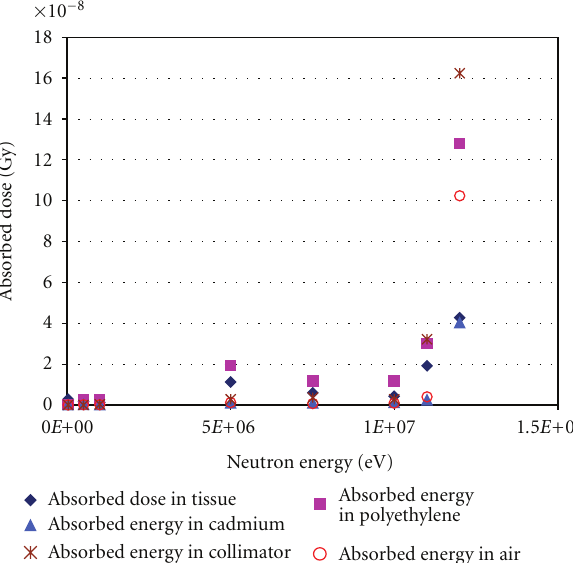
Figure 11: The absorbed doses in the liver tissue and other compo- nents obtained by MCNP4C.